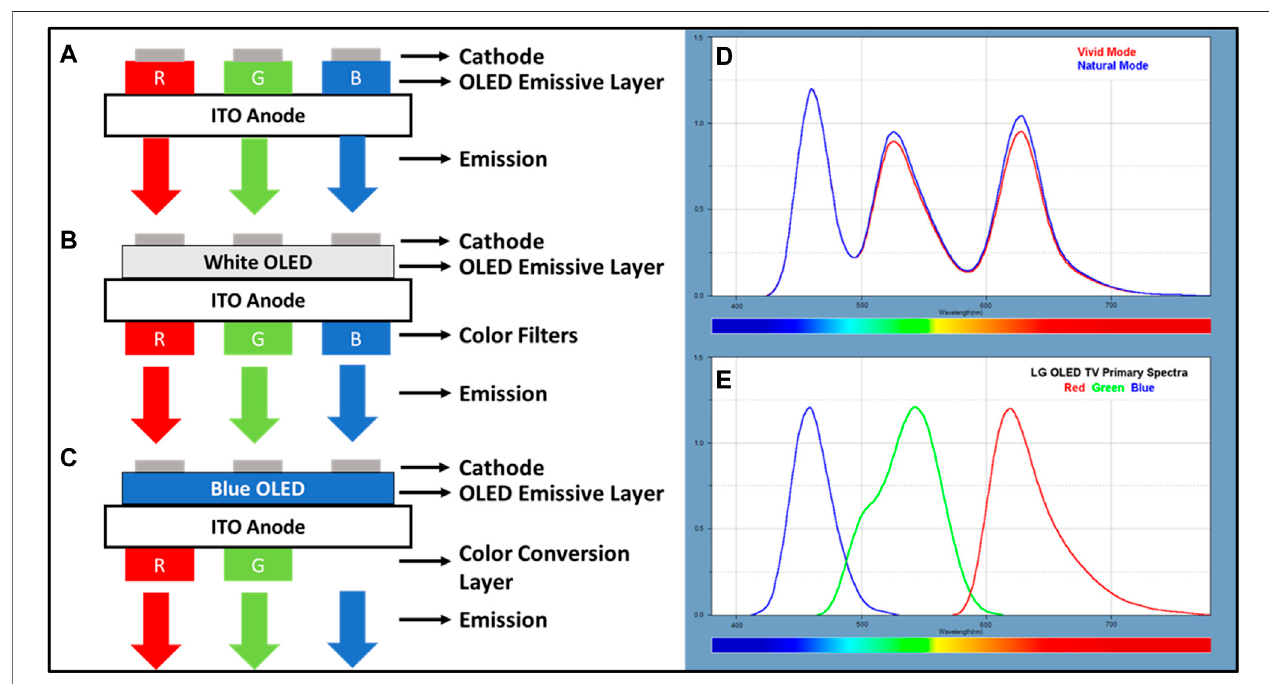
FIGURE4| Full-colorstructure of (A) RGBOLED, (B) WOLED,and (C) colorconversion OLED (Yin etal., 2019).Spectraof (D) AMOLED onSamsung Galaxy S10 (Displaymates, 2019) and (E) WOLED on LG OLED TV (Soneira,